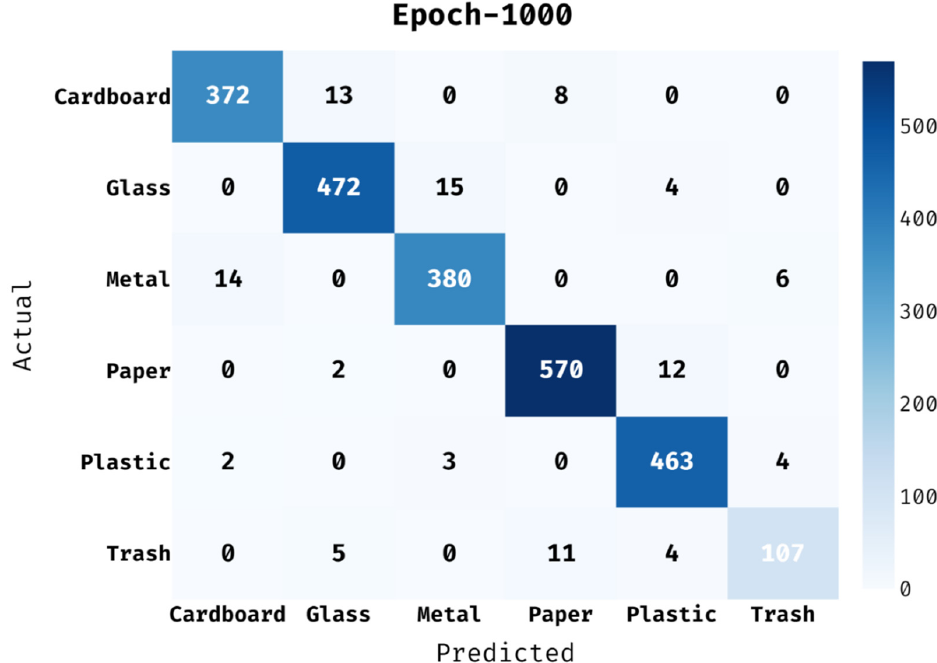
Figure 5. Confusion matrix of DLSODC-GWM technique under 1000 epochs.